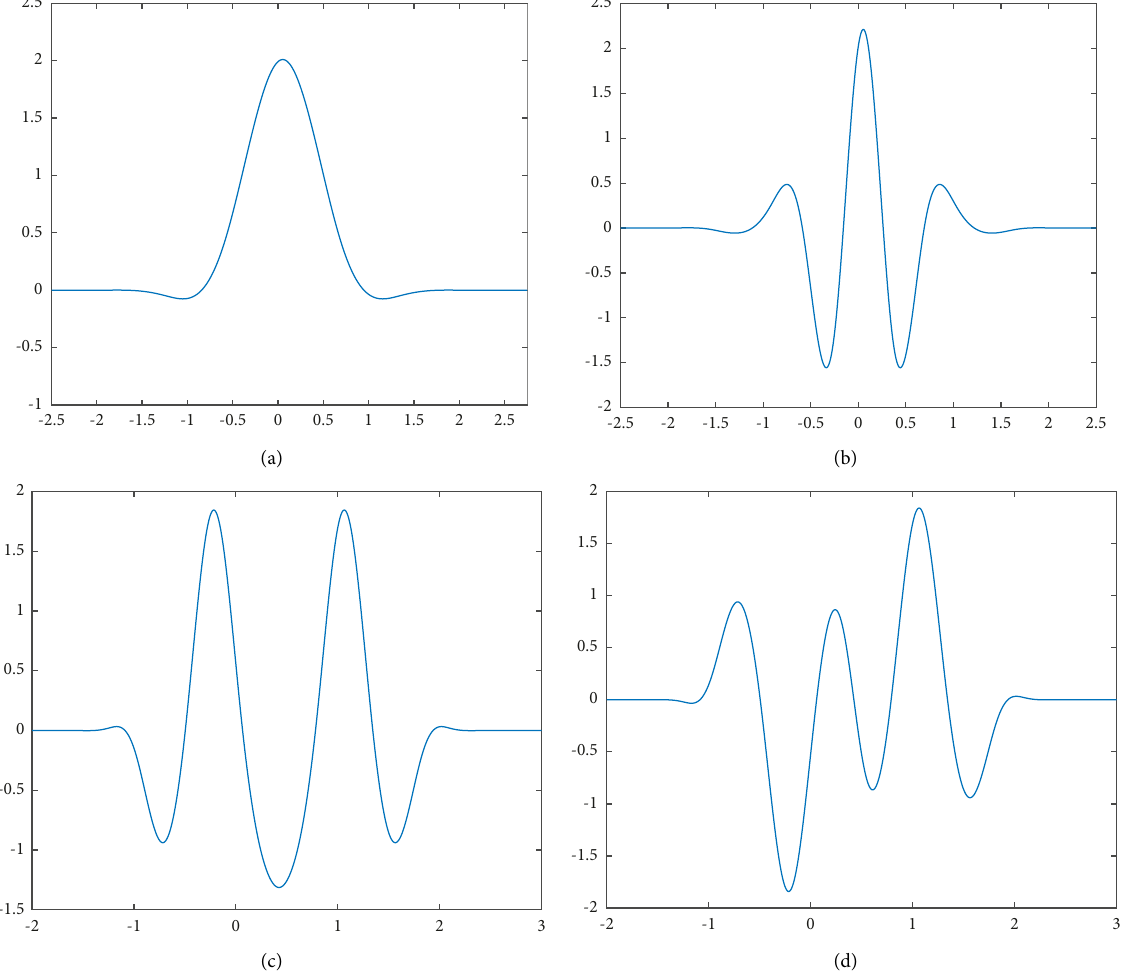
Figure 1: Graphs of the scaling function and the corresponding